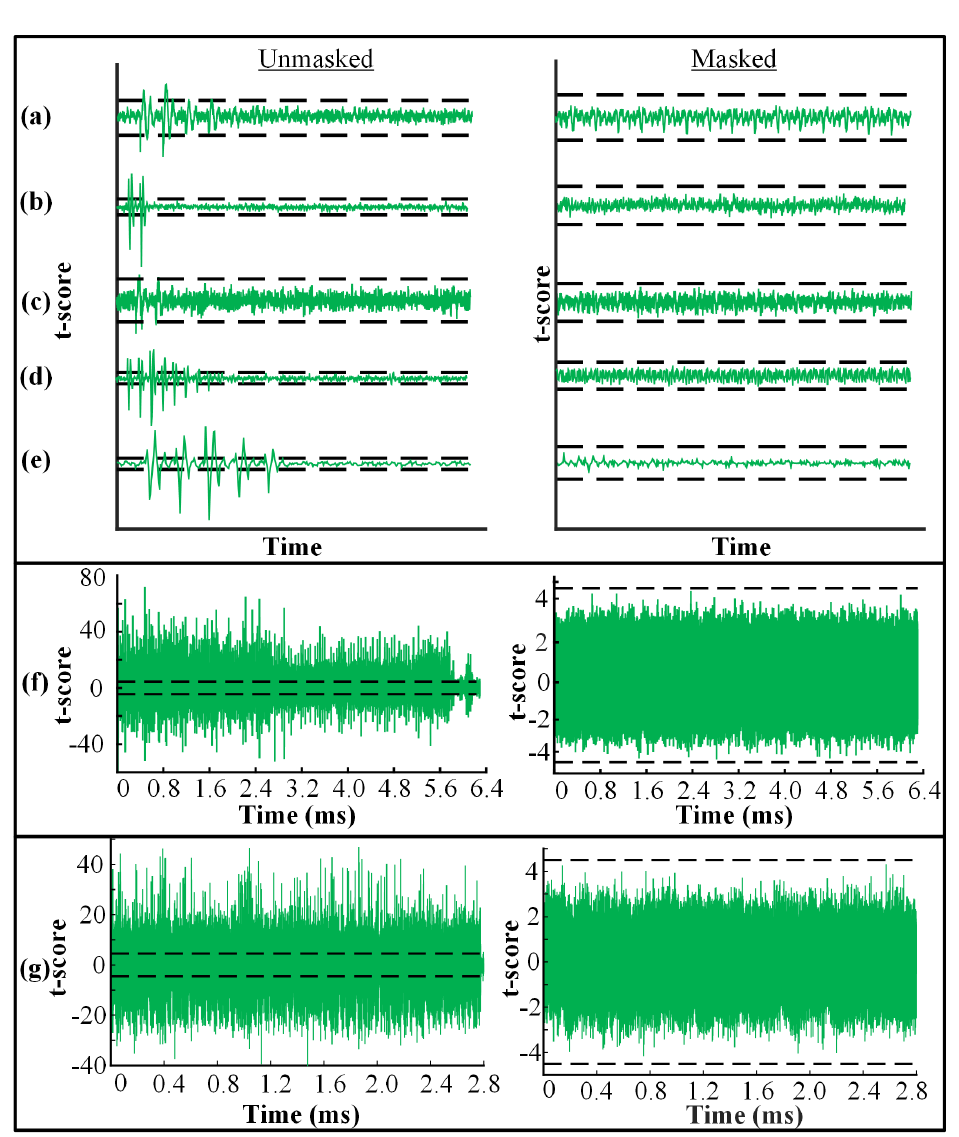
Figure 18: All the plots show TVLA results with PRNGs disabled on the left and PRNGs enabled on the right. The dotted lines signify the TVLA threshold of ± 4.5 which statistically implies a 99.99% confidence. Plots (a)-(e) show results for the individual components of the neural network viz. masked activation function, Boolean-to arithmetic converter, arithmetic-to Boolean converter, masked comparator, and masked multiplexer in the same order. The plots (a)-(e) are shown on a common time axis for visual aid; the execution times are different across every component. Plot (f) shows the results for the hidden and output layer computations. We only present the t-scores for hidden and output layer computations because during input layer computations we cannot evaluate a potential leakage directly due to input correlations: the hardware loads and masks the input pixels on-the-fly throughout the processing of the input layer. Therefore, we create another design which buffers all the masked input pixels and the corresponding masks instead of generating them on-the-fly. The hardware directly reads the input pixels only once during the creation of the arithmetic shares. Figure 18 (g) shows the results for this experiment. In all the plots we observe t-scores higher than the threshold for the unmasked design and t-scores within the threshold for the masked equivalents which demonstrates a significant decrease in the side-channel